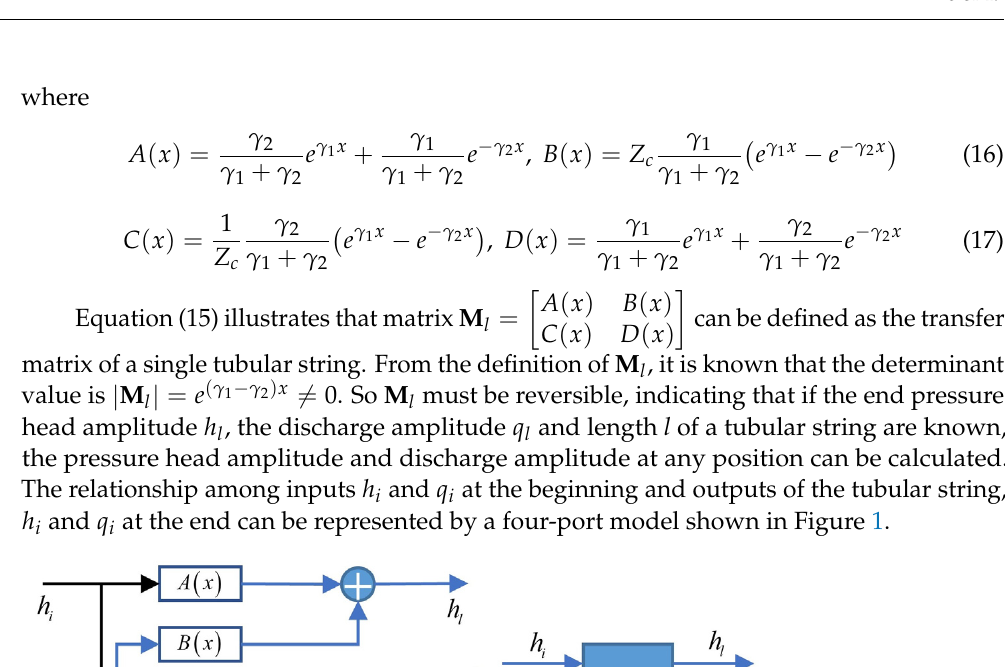
Figure 1. Single pipe four-port equivalence model.